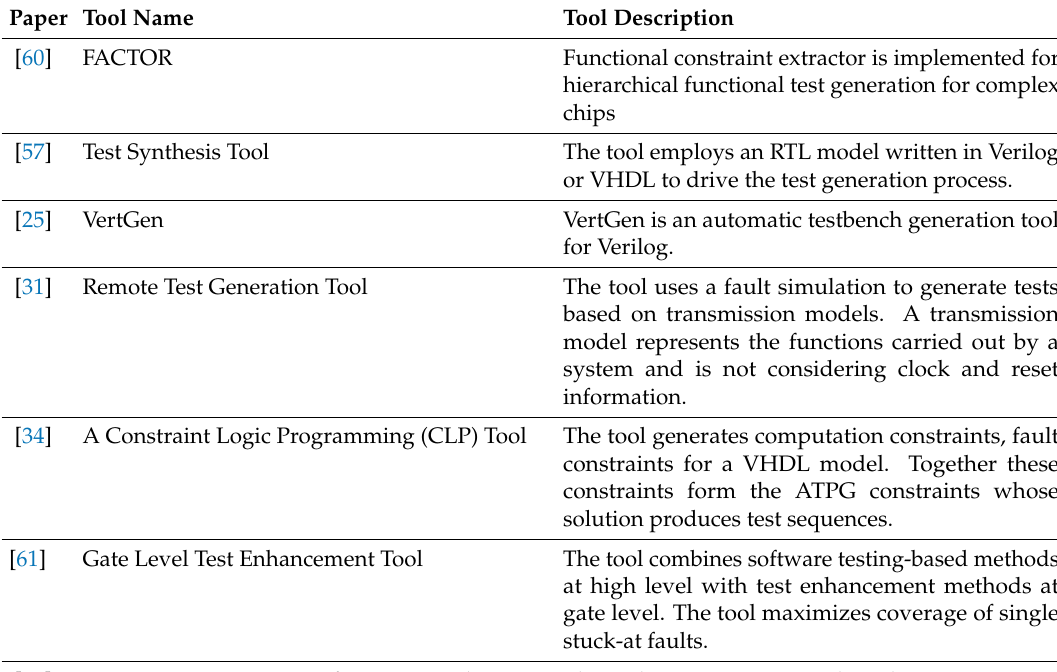
Table 3. List of method for test generation implemented as software